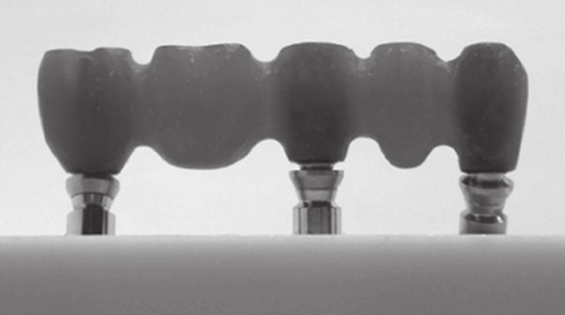
Figure 2- I-Bridge ® 2 master framework made of acrylic resin